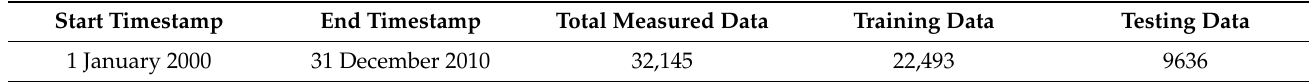
Table 1. FINO3 weather datasets’